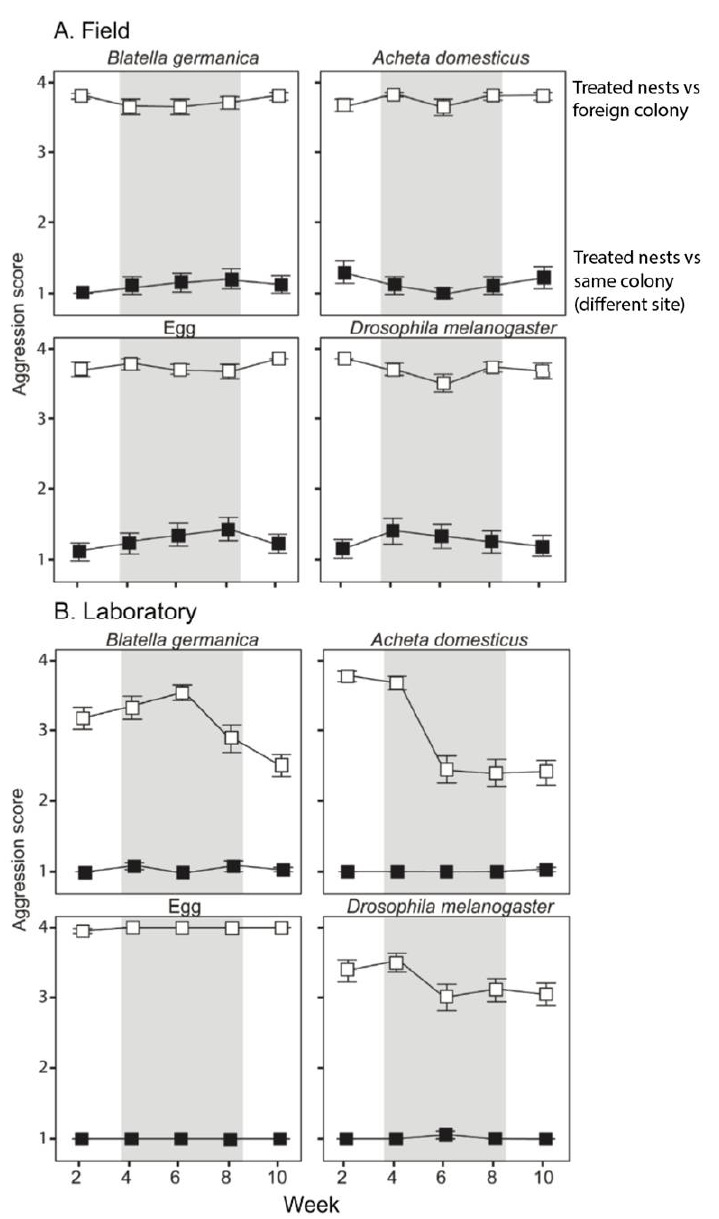
Figure 1. Levels of aggression through time in the dietary experiments ( A ) in the field and ( B ) in the laboratory. The heading of each sub − panel indicates the respective dietary treatment. Open squares show the level of aggression displayed by ants from treatment colonies (from the large Californian supercolony) toward ants from a foreign supercolony (Lake Skinner); Filled symbols show the level of aggression displayed by ants from treatment colonies toward ants from a different site (Mason Regional Park) that belongs to the same supercolony. Shaded portions indicate the time period during which the respective dietary items were provided. Table 1. Mean level of aggression (±SD), before, during and after the dietary experiments in the field. Z scores and p values are from Mann-Whitney U-tests. Bold indicates p < 0.05. Before During After Before vs. During During vs. After Opponent